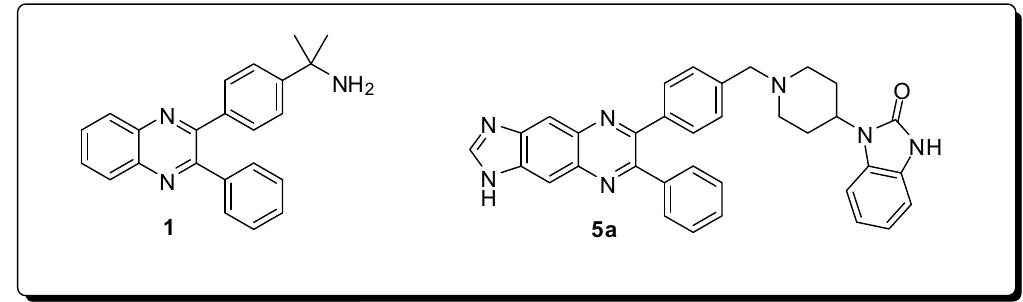
Figure 3. The diphenylquinoxaline 1 ( hit obtained by HTS) and compound 5a , compounds able to inhibit the in vivo phosphorylation of Akt.